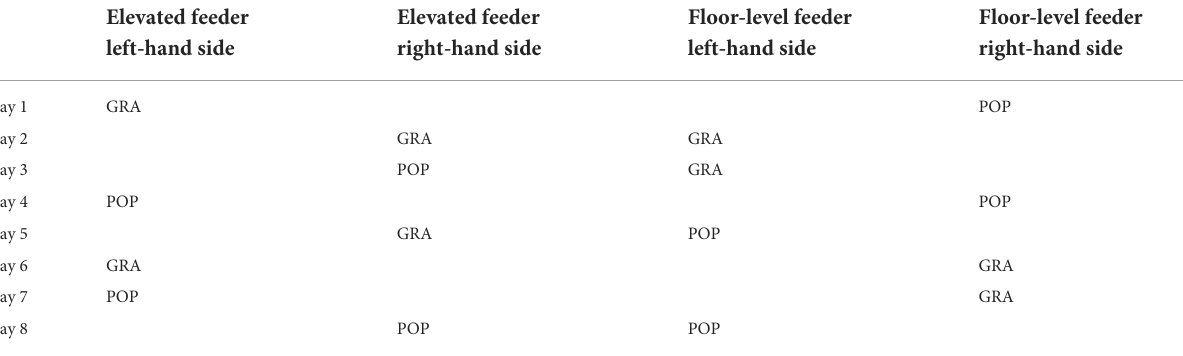
TABLE 1 Example of testing schedule for one goat as determined using an 8x8 Latin Square. The elevated feeder was positioned 1.03m from the ground and the floor-level feeder was positioned 0.30m from the ground (see Figure 1). Elevated feeder Elevated feeder Floor-level feeder Floor-level feeder left-hand side right-hand side left-hand side right-hand side